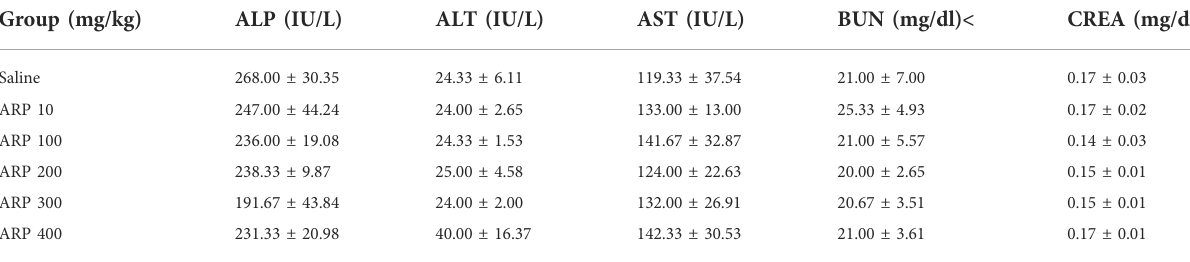
TABLE 1 Biochemical parameters of mice with ARP water extract in acute toxicity test. Group